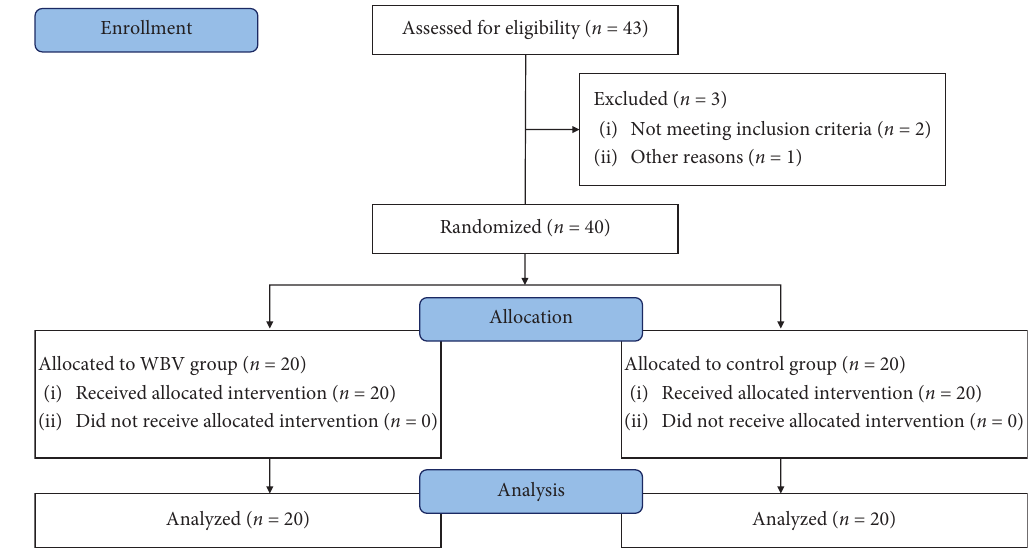
Figure 1: Flowchart of the study. WBV, whole-body vibration.